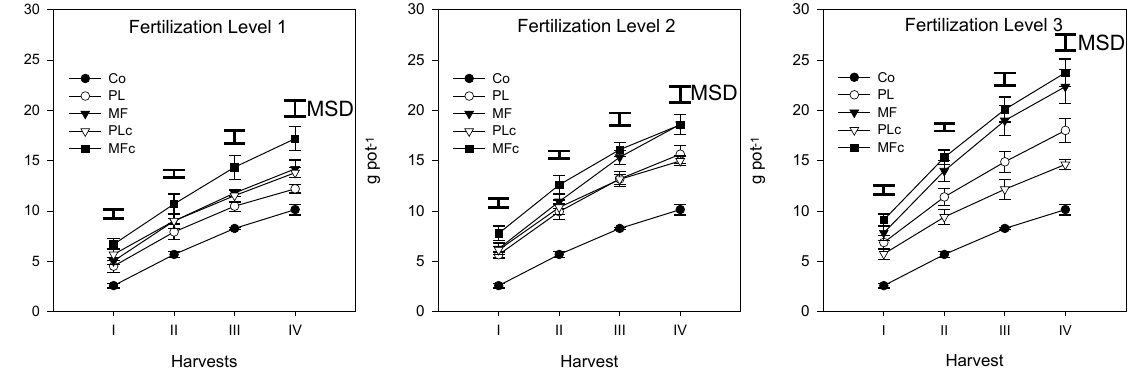
Figure 2: Cumulative biomass yields (DM g/pot) of 4 consecutive harvests (I-IV) of ryegrass ( Lolium perenne ) at 3 fertilization levels (1.5, 3 and 6 t/ha) and an unfertilized control CO = control, PL = poultry litter, MF = mineral fertilizer, PLc = carbonized poultry litter MFc = mineral fertilization based on PLc, means and standard errors, n = 4, MSD indicates the minimum significant difference (p ≤ 0.05, Student-New- man-Keuls